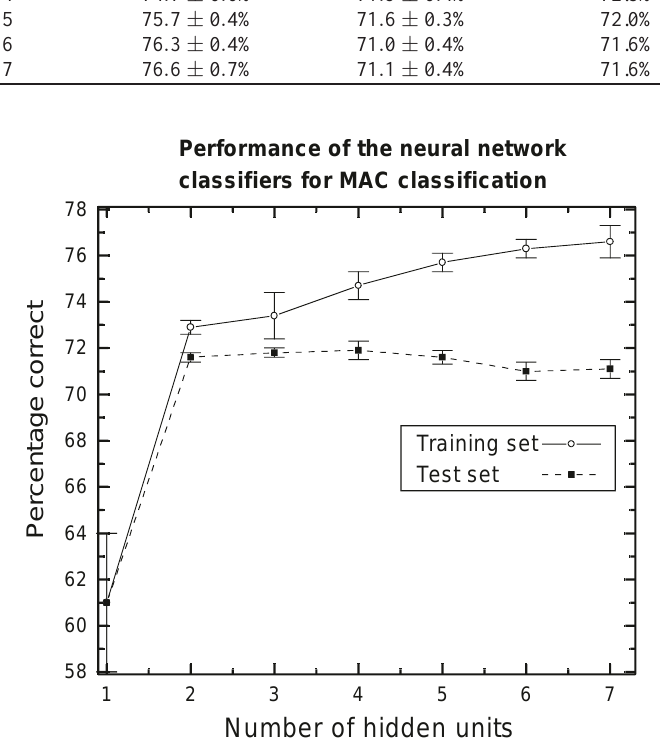
Fig. 1. The cell-by-cell classification rate of neural networks with different numbers of hidden units is shown for the training and test sets. Each result is the average of 20 runs using randomly initialized networks. The standard deviations are shown as error bars for each